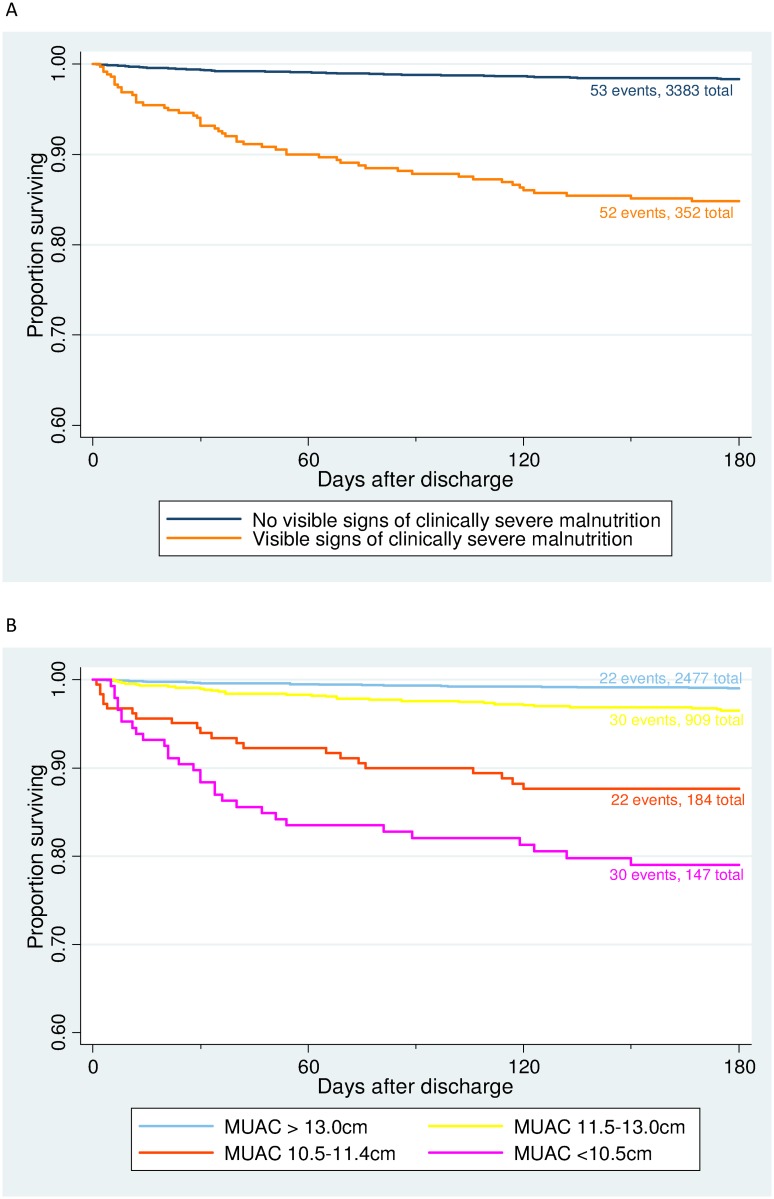
Kaplan-Meier survival estimates for 105 deaths during 180 day follow-up after discharge of 3735 children from Basse Health Centre, by categories of (A) clinically severe malnutrition and (B) mid-upper arm circumference.Clinically severe malnutrition was defined as the presence of visible wasting of the buttocks, characteristic skin or hair changes, or bilateral pedal oedema. Fifty-five patients exited alive from the Basse HDSS during 180 day follow-up. Numbers of events refer to the number of post-discharge deaths in each category. Total numbers refer to numbers of children in each category at the beginning of follow-up. Abbreviations: MUAC, mid-upper arm circumference (measured in centimetres).